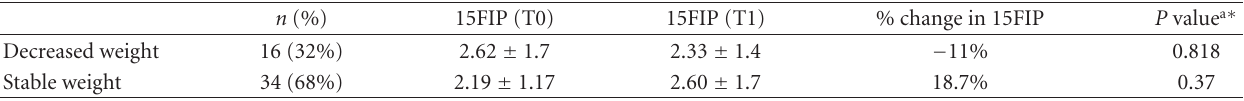
Table 5: Changes in 15FIP according to weight status before and during RIF.